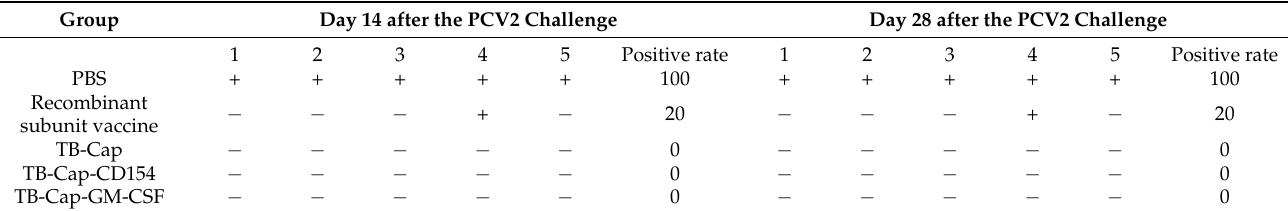
Table 4. The viremia of different immune groups.